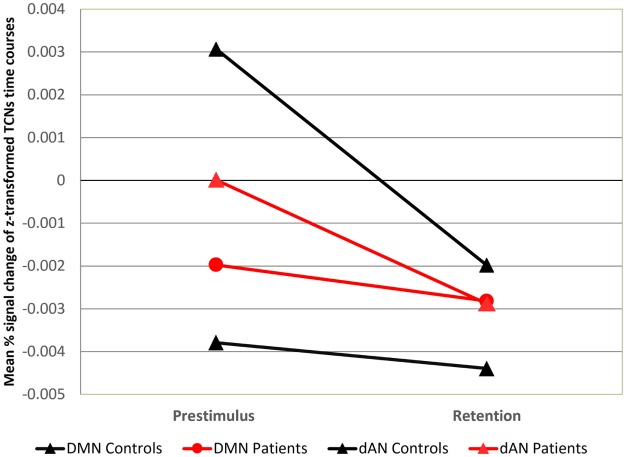
Mean DMN and dAN from pre- to poststimulus in the WM task. Mean DMN and dAN dynamics at prestimulus and retention intervals for each load and group. X-axis: time points (prestimulus and retention period), Y-axis: mean percent signal change of variance normalized, and z-transformed TCNs.